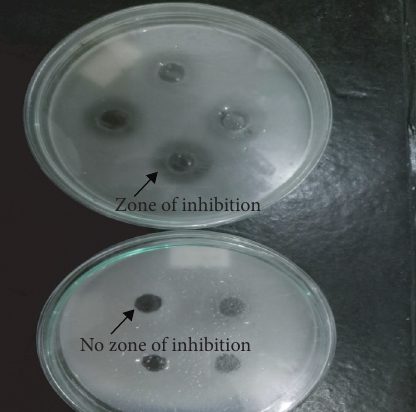
Figure 7: Secondary screening of isolates. Two plates showing the agar well diffusion method (top: the plate with zone of inhibition to bacterial lawn (as shown by arrow); below: the plate without zone of inhibition to bacterial lawn).